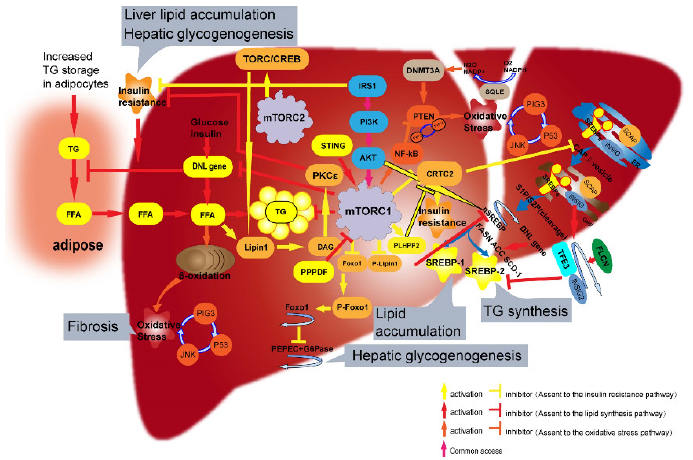
Figure 2. mTOR affects NAFLD through lipid metabolism (SREBPs), insulin resistance (Lipin1, Foxo1), and oxidative stress (PIG3, p53, JNK). (a). Excessive amounts of triglycerides stored in fat